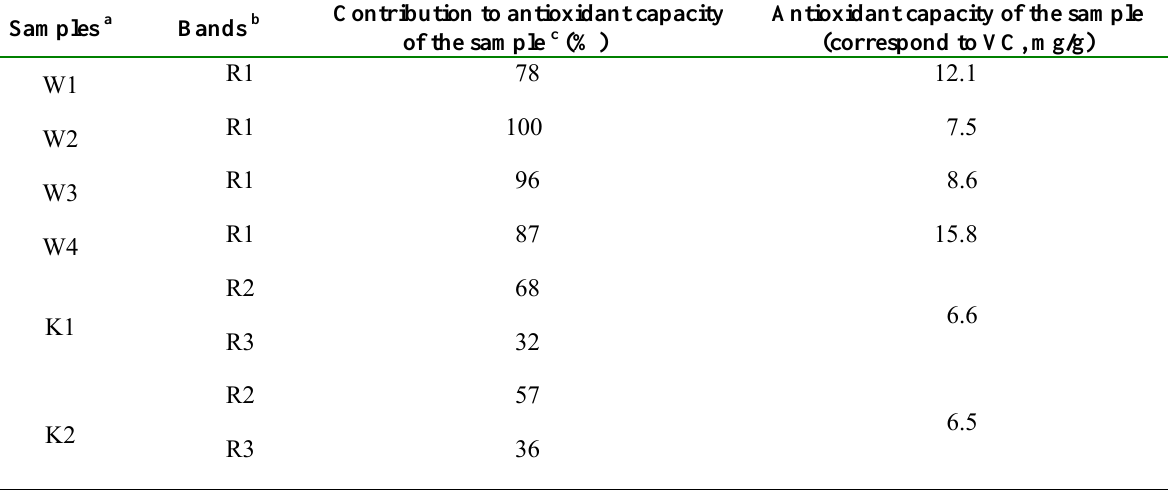
Table 2. Antioxidant ability of four species of Curcuma , volatile oil of C. wenyujin and C. longa. Samples